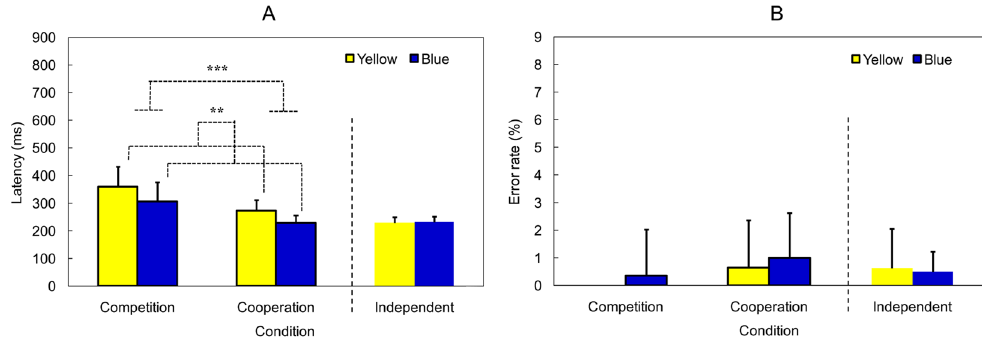
Figure 3. ( A ) Mean manipulation latency and ( B ) mean error rate in the competition, cooperation, and independent conditions. The error bars represent standard deviation. ** and *** indicate p < 0.01 and p < 0.001, respectively.